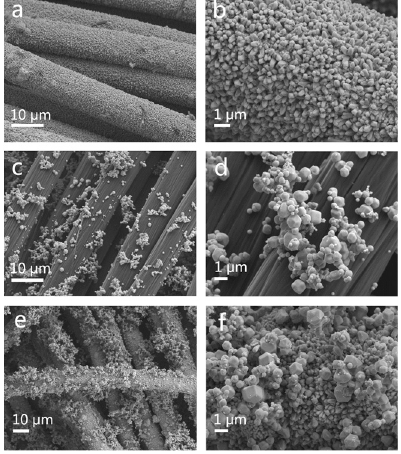
Figure 2. SEM images of the SnO 2 /CC ( a , b ), Ag 3 PO 4 /CC ( c – d ), Ag 3 PO 4 /SnO 2 /CC ( e – f ).